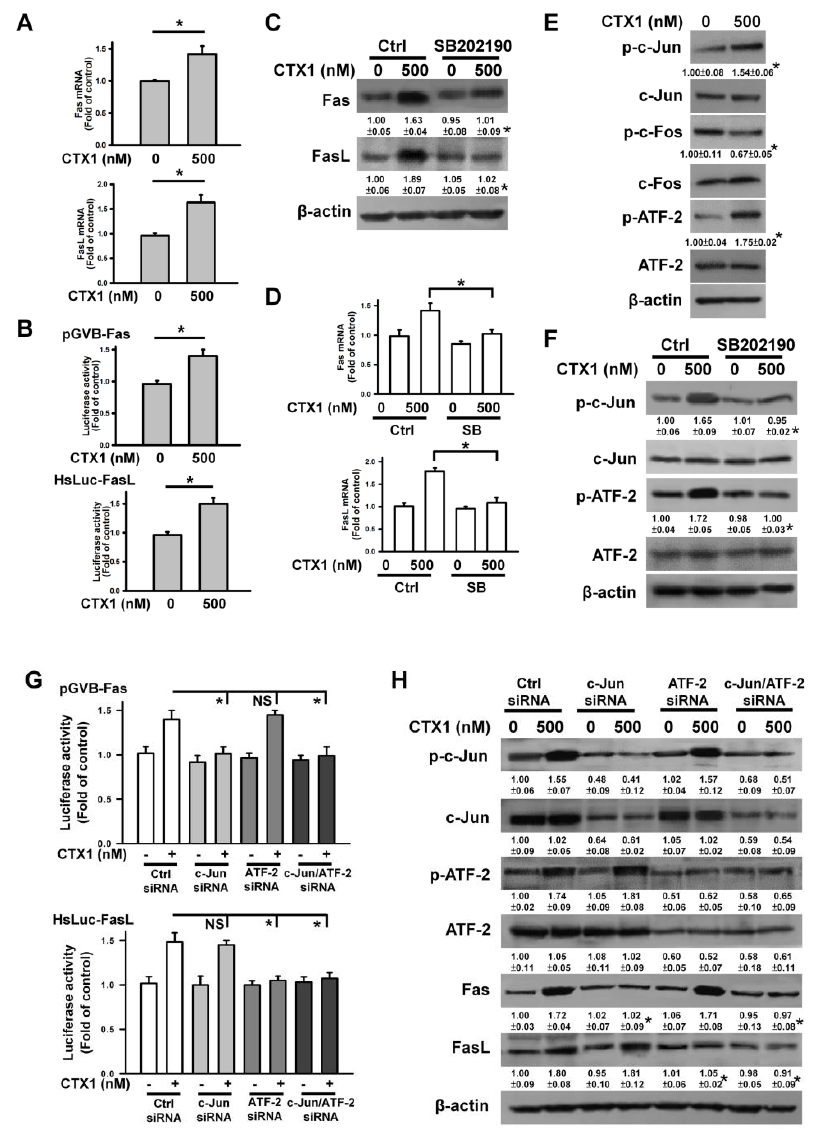
Figure 5. CTX1 induced upregulation of Fas and FasL in U937 cells through p38 MAPK-mediated phosphorylation of c-Jun and ATF-2. U937 cells were directly treated with 500 nM CTX1 for 4 h, or pretreated with 10 μM SB202190 for 1 h and then incubated with 500 nM CTX1 for 4 h. ( A ) Detecting the expression of Fas and FasL using qRT-PCR. qRT-PCR was conducted according to the procedure described in the Materials and Methods section (mean ± SD, * p < 0.05). ( B ) CTX1 treatment elicited increase in transcriptional activity of Fas promoter and FasL promoter (mean ± SD, * p < 0.05). After transfection with indicated promoter constructs for 24 h, the transfected cells were treated with 500 nM CTX1 for 4 h and then harvested for measuring luciferase activity (mean ± SD, * p < 0.05). ( C ) Effect of SB202190 on the expression of Fas and FasL proteins in CTX1-treated cells (* p < 0.05, SB202190/CTX1-treated cells compared to CTX1-treated cells). ( D ) Effect of SB202190 on the expression of Fas and FasL mRNAs in CTX1-treated cells (mean ± SD, * p < 0.05). ( E ) Effect of CTX1 treatment on levels of p-c-Jun, p-c-Fos and p-ATF-2 (* p <0.05, CTX1-treated cells compared to untreated control cells). ( F ) Effect of SB202190 on CTX1-induced c-Jun and ATF-2 phosphorylation (* p < 0.05, SB202190/CTX1-treated cells compared to CTX1-treated cells). ( G ) Depletion of c-Jun or ATF-2 using siRNA inhibited the transcriptional activity of Fas and FasL promoter constructs in CTX1-treated U937 cells. U937 cells were co-transfected with Fas promoter/FasL promoter constructs and indicated siRNAs. The used concentration of control siRNA, c-Jun, and ATF-2 was 100 nM. After 24 h post-transfection, the cells were treated with 500 nM CTX1 for 4 h (mean ± SD, * p < 0.05; NS, not statistically significant). ( H ) Suppression of c-Jun or ATF-2 expres- sion abrogated CTX1-induced Fas and FasL upregulation in U937 cells. U937 cells were transfect-